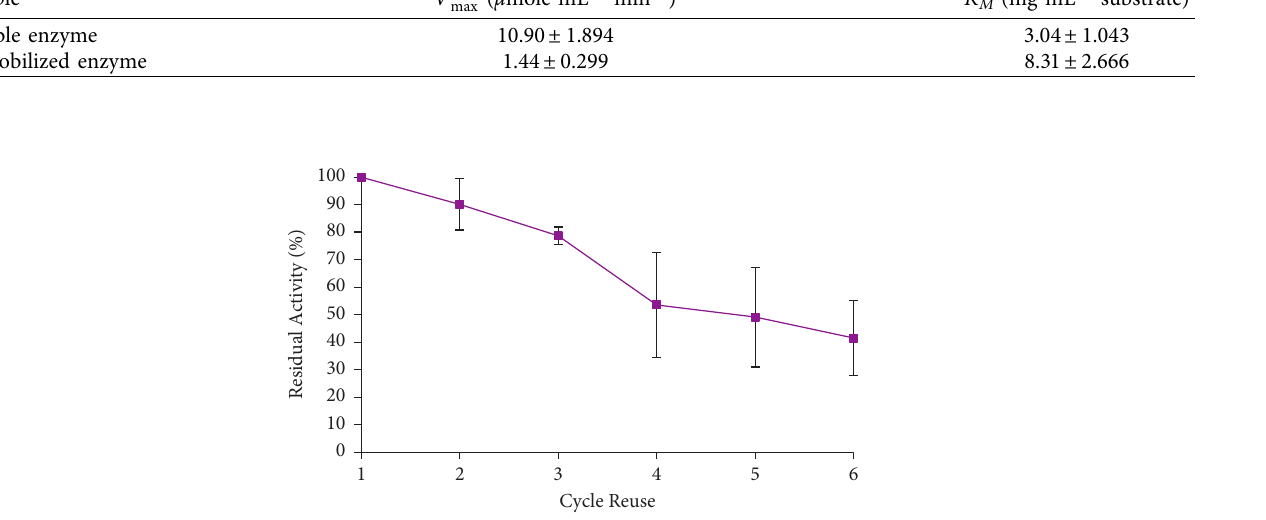
Table 2: K V values for soluble and immobilized enzymes. The kinetic parameters were determined at each optimum temperature M and max and the starch concentrations from 2.0 to 10.0mg/mL. The values were shown as mean ± SD, n � 2. Sample